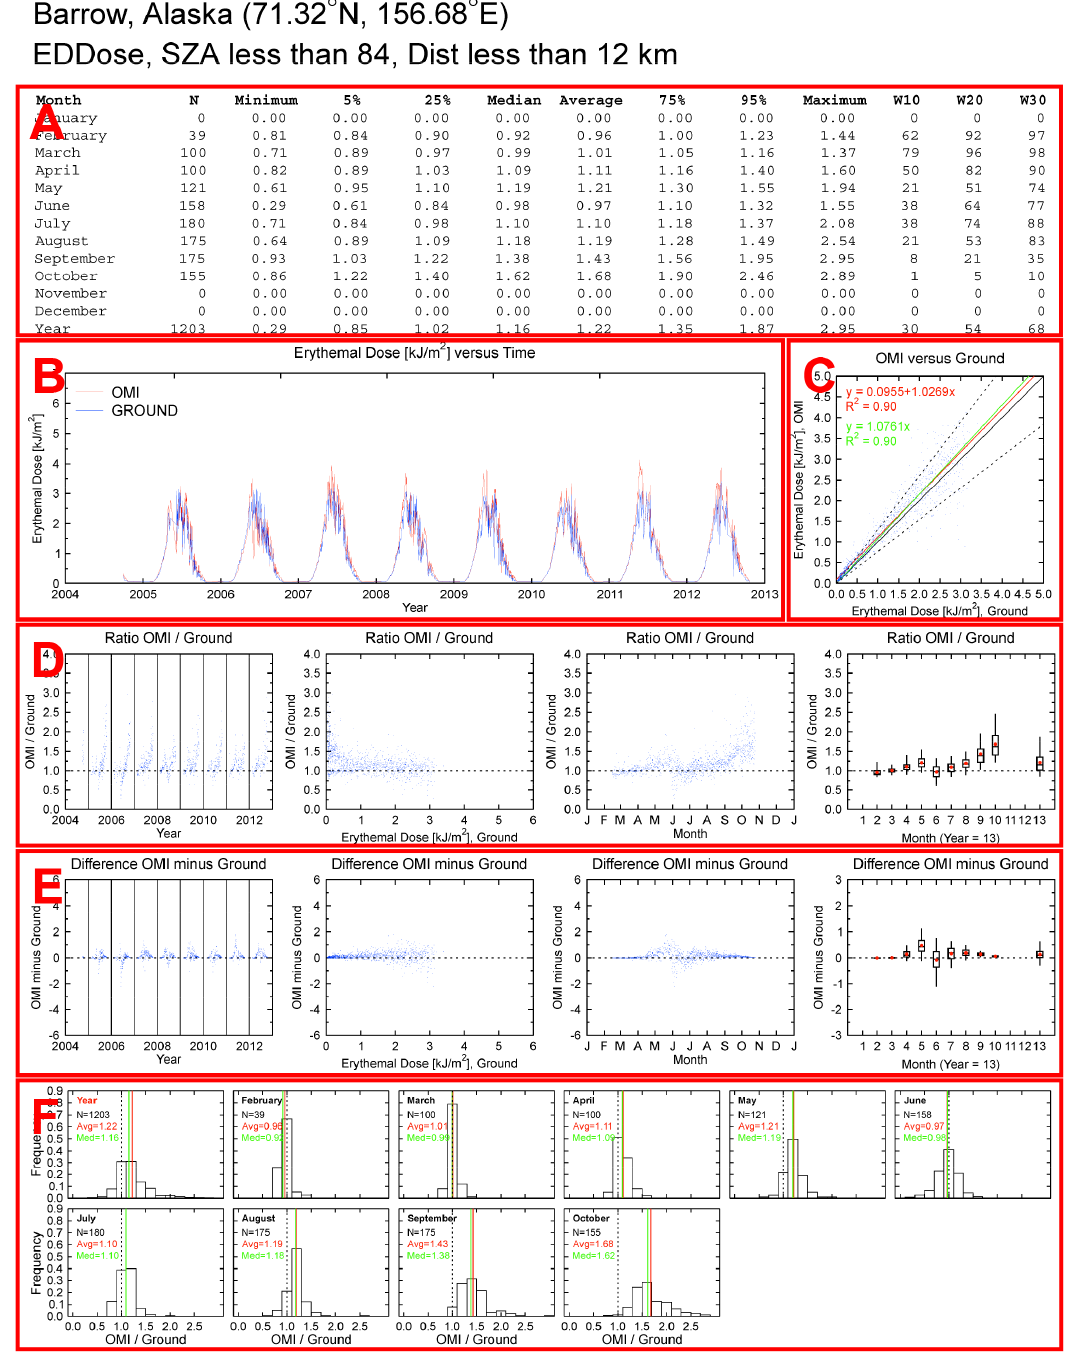
Figure A1. Example of a standardized page summarizing the results of the comparison of OMI and ground-based erythemal daily dose data at Barrow. Additional pages of this type are available as a Supplement. The contents of panels (a) – (f) are explained in the